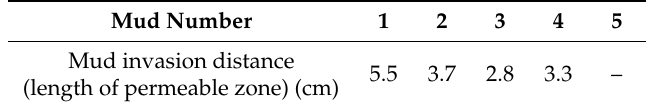
Figure 4. The amount of filtered water varies with loading and time in stratum G1.